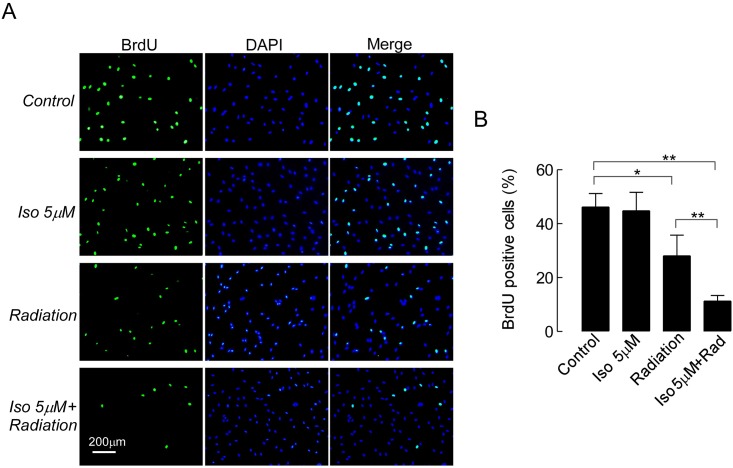
Isoalantolactone combined with radiation inhibits the proliferation of UMSCC-10A cells.(A) Representative images from a cell proliferation assay illustrate nuclear staining after the cells were treated with isoalantolactone at 5 μM for 72 hours or radiation at 4 Gy for 4 hours alone or with a combination. (B) The proliferative ability of UMSCC-10A cells was tested with BrdU incorporation assays. The results are representative of three independent experiments. Values represent the mean ± SEM, * P<0.05, **P<0.01compared with the control.